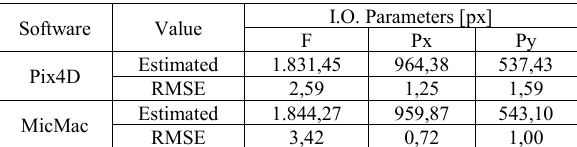
Table 4. Comparison of focal length and the coordinates of the